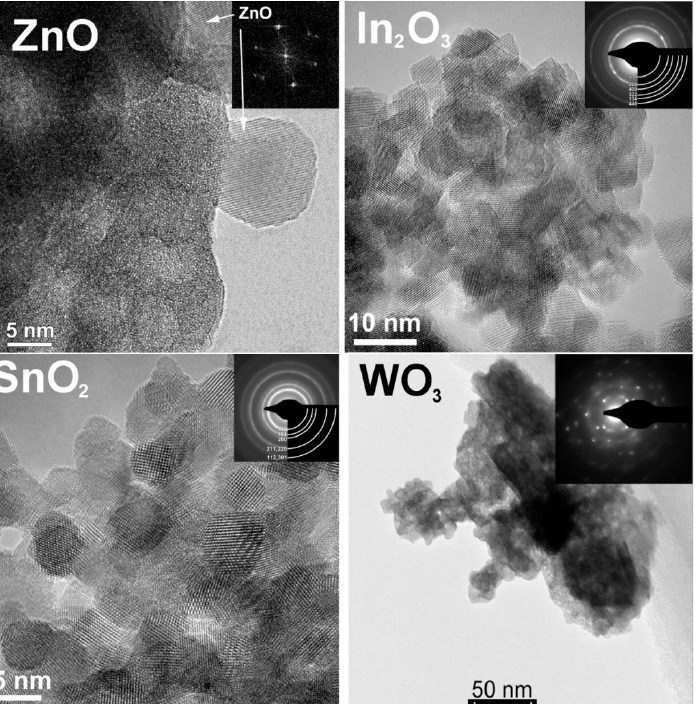
Figure 9. HRTEM images of nanocrystalline ZnO, In 2 O 3 , and SnO 2 , and TEM image of WO 3 ; the sample were annealed at 300 °C. The insets show electron diffraction patterns. Adapted with permissions from ref. [42] copyright 2019 by the authors (CC BY); ref. [76] copyright 2019 by the authors (CC BY); ref. [94] copyright 2015 Elsevier; ref. [95] copyright 2013 American Chemical Society.